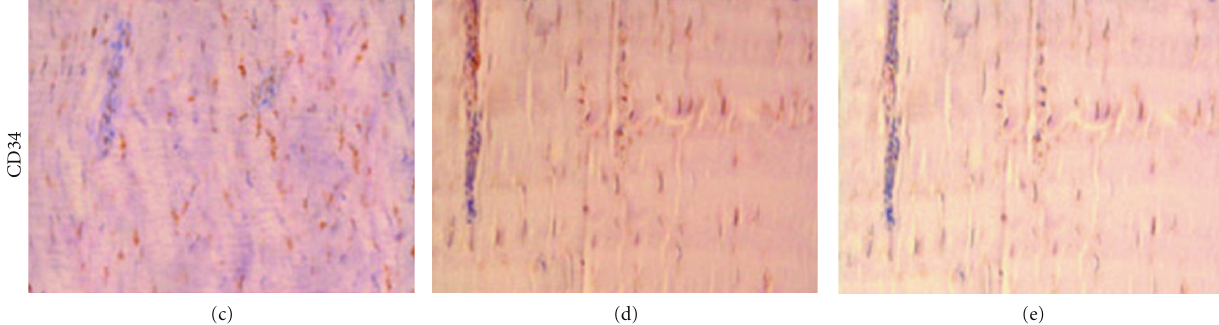
Figure 4: (T21) Tissue slides from the superficial digital flexor tendons (SDFT) following experimentally induced tissue injury and subsequent treatment with Fibrin (c), Saline (d), and normal tendon (e). Tissue stains with hematoxylin-eosin (H and E) and Herovyci (Hero) show loss of the longitudinal fiber pattern and crimp in tendons treated with-Fibrin (c); in Saline treated tendon (d), there is complete disruption with randomly oriented fibers, clearly shown in the central area. The collagen I/III ratio in Fibrin treated tendon (c) is clearly lower than in normal (e) and cell grafted tendon (Figures 3(a) and 3(b)); in Saline (d) treated tendon, the central zone was highly positive for collagen type III but not for type I. Stains for cartilage oligomeric matrix protein (COMP) show stack and spread expression in both control-treated SDFT (c-d). In immunohistochemistry staining for the expression of CD34+ mononucleated cells in Fibrin (c), Saline (d) and Normal (e) Tendon, only sporadic CD34+ stained mononuclear elements were detected. By contrast, in all three placebo-treated SDFTs, the location of the lesion was readily identified as an area with high positivity for type III collagen, very low expression of type I collagen and in some zones, evidence of mineralization. Similarly to the trend of type I collagen expression, COMP was expressed in a homogeneous and di ff use pattern in sham untreated control SDFTs as well as in cBMSC- and BMMNCS-injected tendons. Scant, weak expression of COMP, restricted to areas that circumscribed the injected portions of the tendon, was observed in all three placebo-treated SDFTs. As expected, no CD34+ mononuclear cells were observed in the sham tendon sections. Similar results were obtained in sections of placebo-injected SDFTs, although a certain number of inflammatory cells were present, interspersed in perivascular areas of these tendons (data not shown). Only sporadic CD34+ stained mononuclear elements (i.e., 0 to 2 per HPF) were observed in cBMSC-injected tendons (data not shown). On the contrary, in BMMNCS-treated SDFTs large numbers of mononucleated cells, in part CD34+ stained, were present in the interfascicular